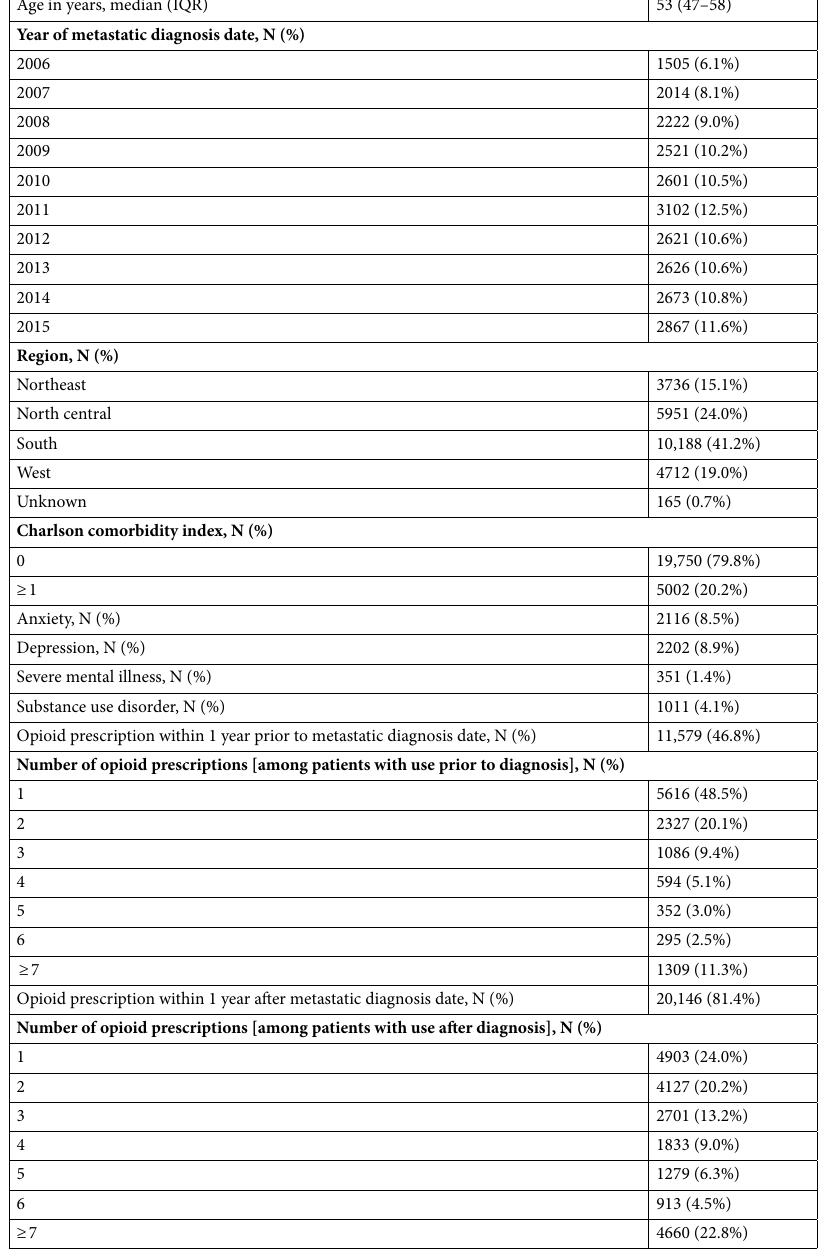
Table 1. Patient characteristics and opioid